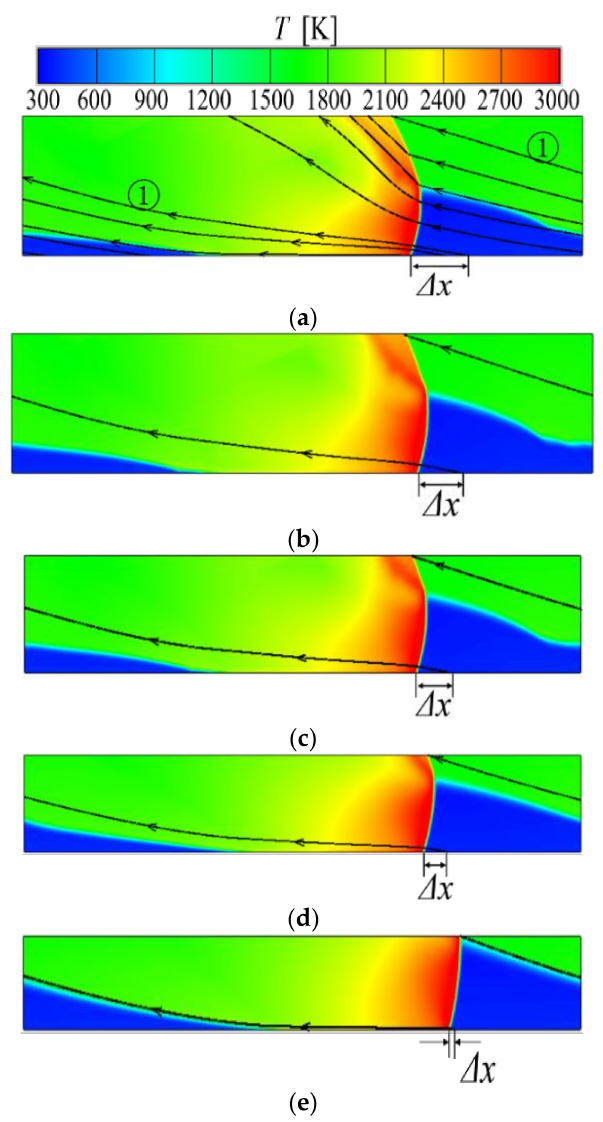
Figure 16. Temperature contours of CRD combustors with different axial lengths: ( a ) L = 200 mm; ( b ) L = 175 mm; ( c ) L = 150 mm; ( d ) L = 125 mm; and ( e ) L = 100 mm at time of 6920 µ